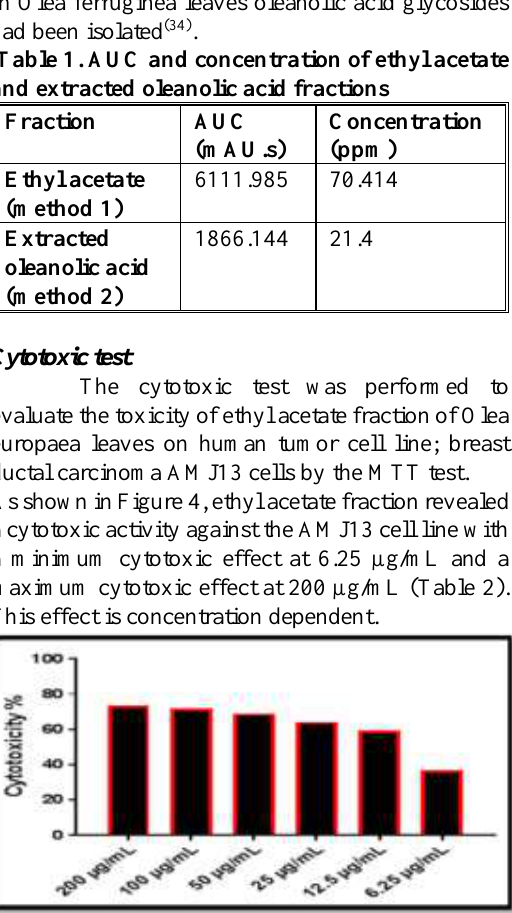
Figure 4. Effect of ethyl acetate fraction over AMJ13 cell growth. The results are expressed as % of cytotoxicity.